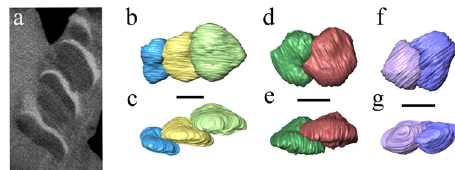
Fig. 7 CT images showing the tooth histology and resorption of Sclerocormus cf. S. parviceps (HFUT MJS-16-012). a One slice showing the dental histology; white is the enamel cap, dark is dentin, and faint and light- grey bands are formed by incremental lines in dentin. b – g CT images showing the ways in which the teeth contact each other. b , c Posteroventral dentary teeth. d , e Anteroventral dentary teeth. f – g Posterior maxillary teeth. The scale bars are 5